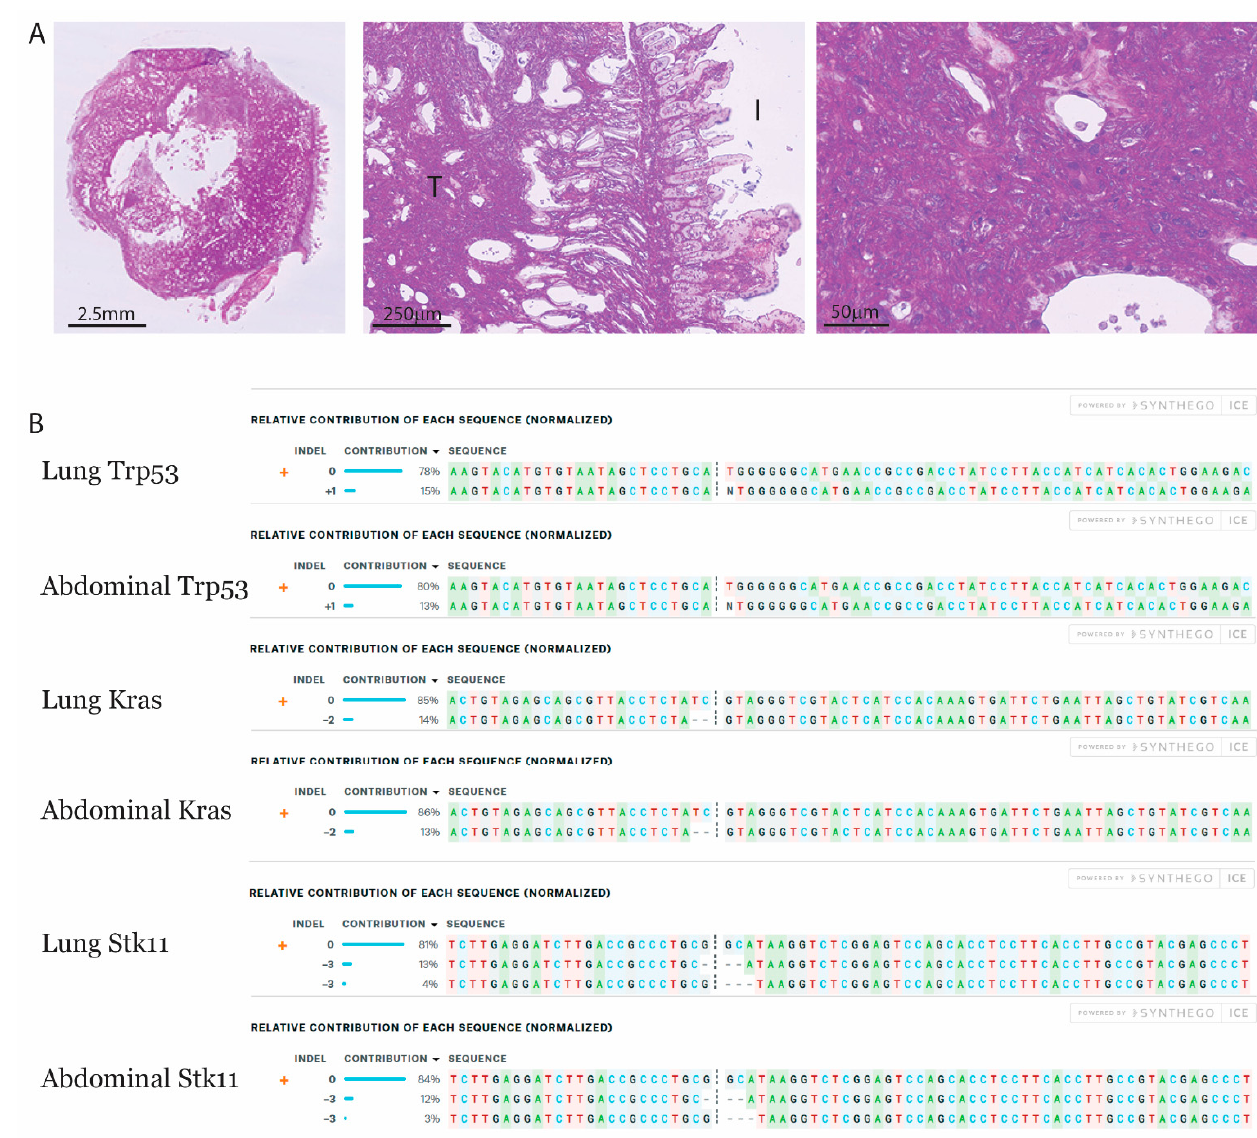
Figure 5. Abdominal metastasis from a primary lung tumor. An abdominal metastasis was present in a mouse with STK induced lung tumor 4 months post-viral transduction. ( A ) H&E stained section of a 5 mm metastasis in the abdomen. The metastasis was associated with the intestine, as intestinal villi were observed (I: intestine, T: tumor). ( B ) Sanger sequencing was performed on the metastasis and the primary lung tumor for target sites of the guide RNAs. The mutation profile was analyzed with ICE software and compared between the samples.